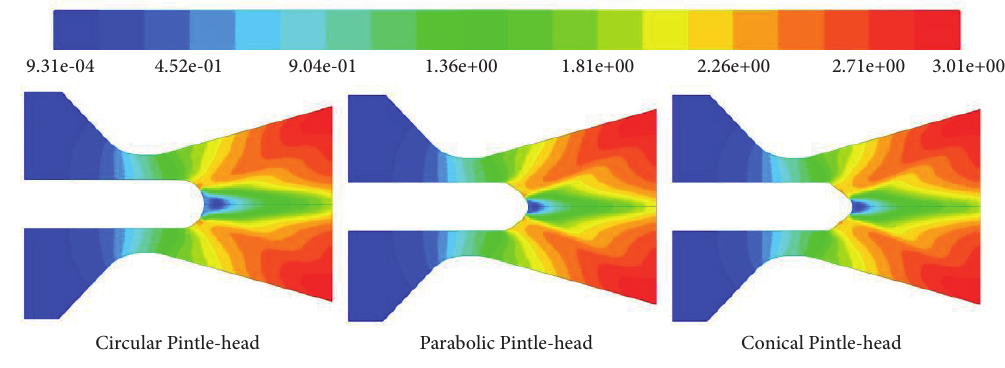
Circular Pintle-head Parabolic Pintle-head Figure 8. Three different pintle models Mach contours at the flow time of 0.2 s.